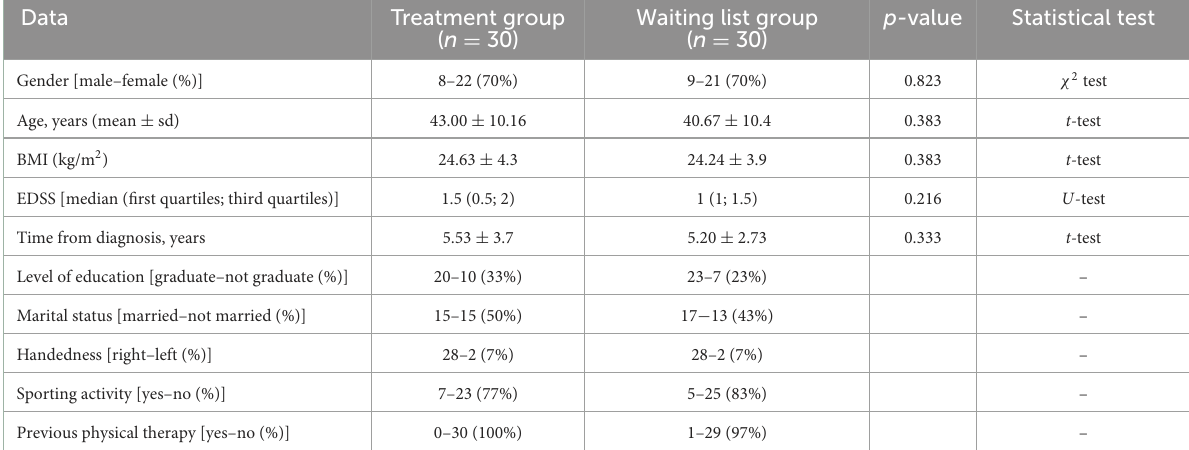
TABLE 2 Sample characteristics.